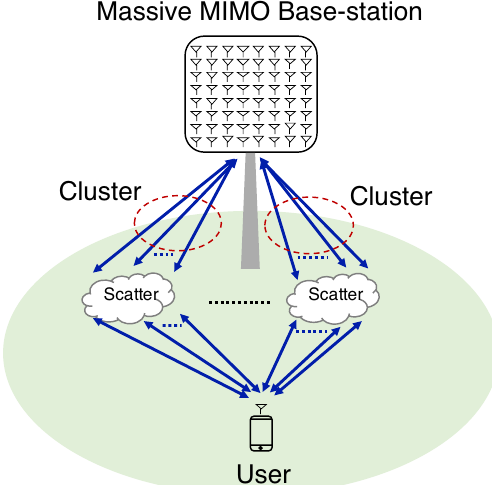
Fig. 1 Propagation paths between a massive MIMO base-station and a single-antenna